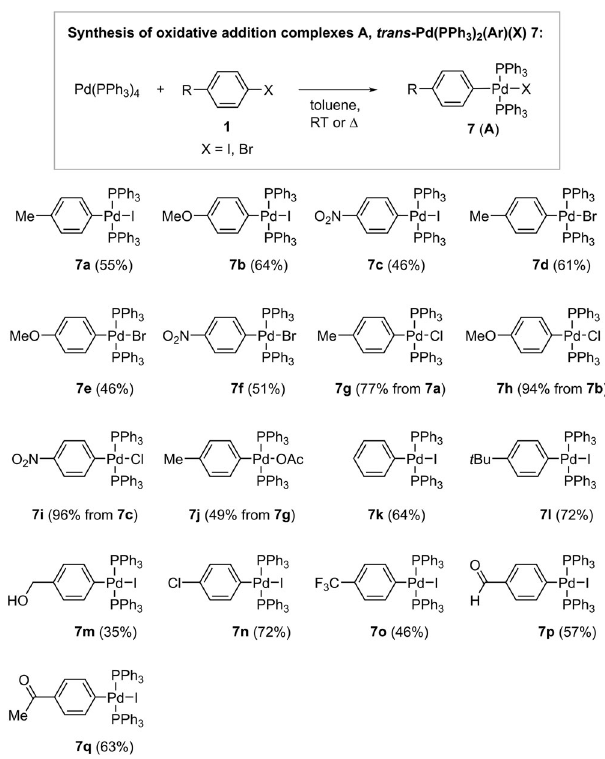
Fig. 5 Synthesized palladium oxidative addition complexes 7, mimics of A. For synthetic details see Supplementary Information (Supplementary Note